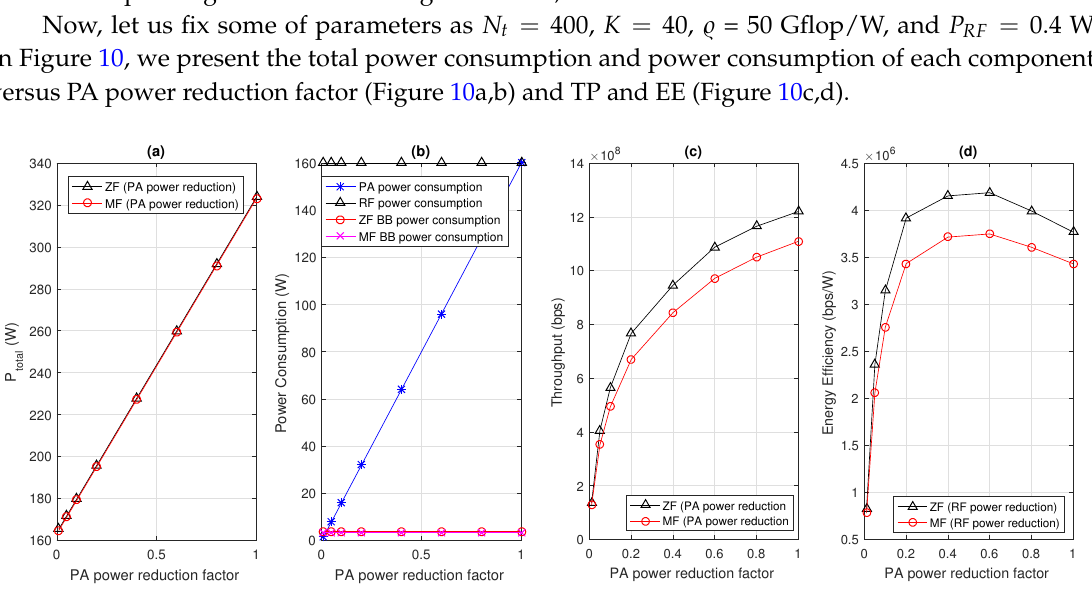
Figure 10. ( a ) total power consumption; and ( b ) power consumption of each component based on PA reduction factor, when N t = 400 and K = 40, (cid:36) = 50 Gflop/W, and P RF = 0.4 W; ( c ) TP; and ( d ) EE when N t = 400 and K = 40, (cid:36) = 50 Gflop/W and P RF = 0.4